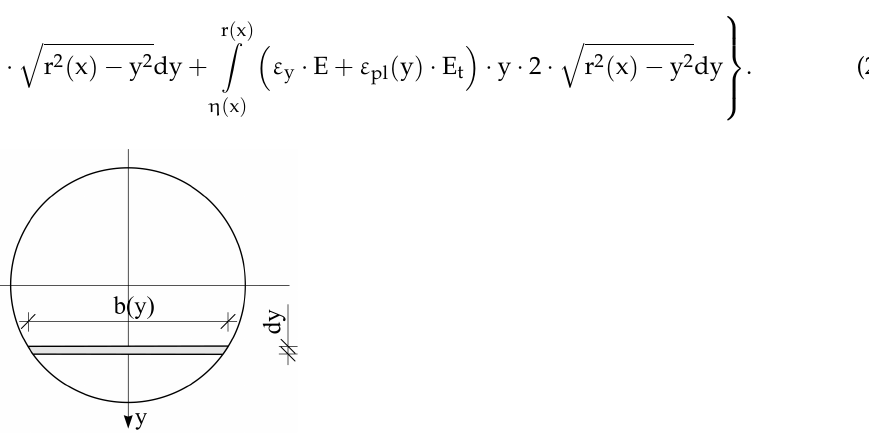
Figure 3. The elemental integration area.